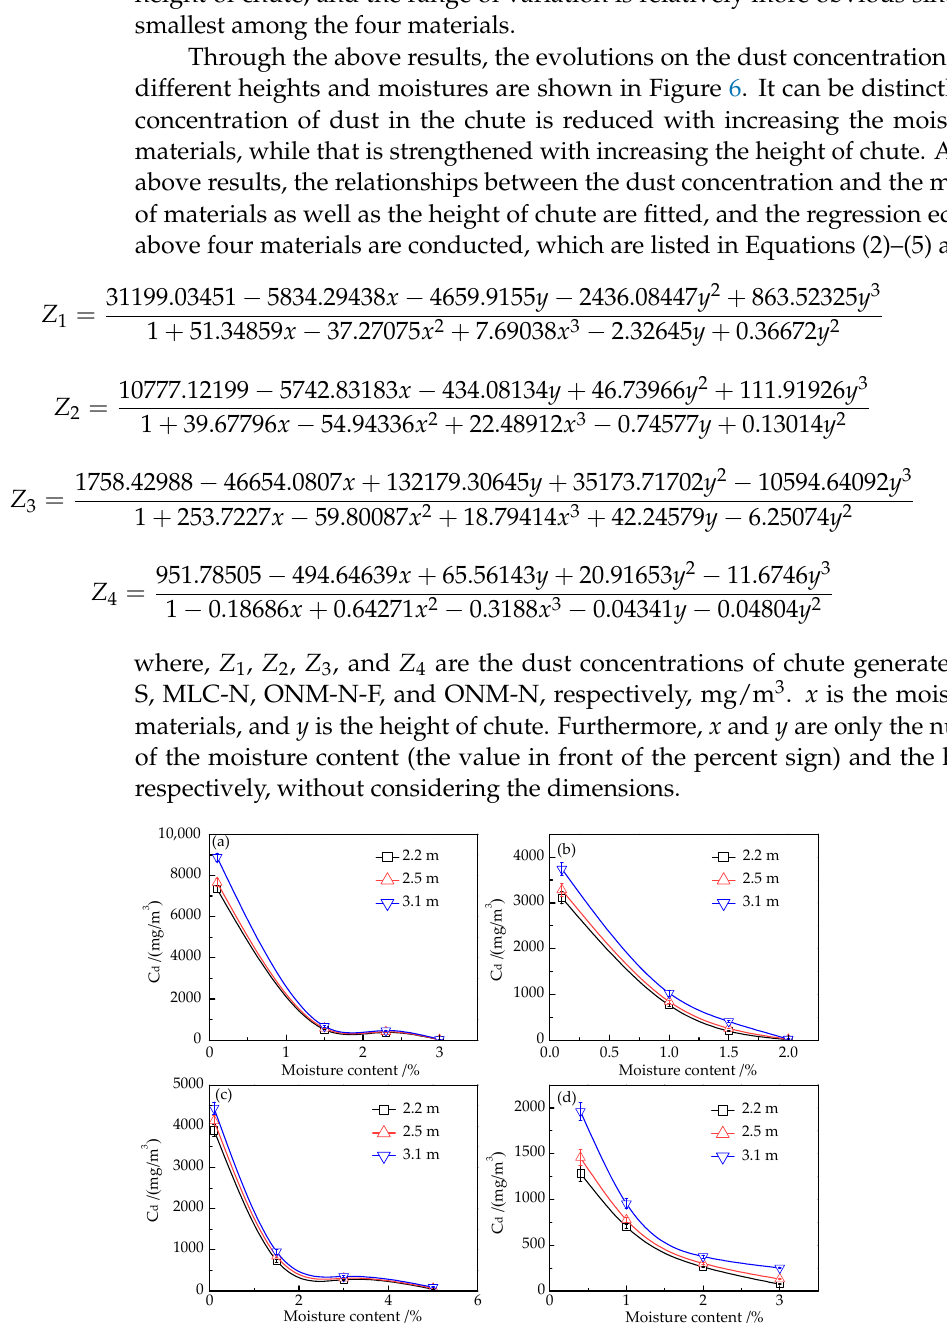
Figure 6. Concentration distribution of dust in the chute under different chute heights and different moistures: ( a ) MLG-S; ( b ) MLC-N; ( c ) ONM-N-F; ( d ) ONM-N.